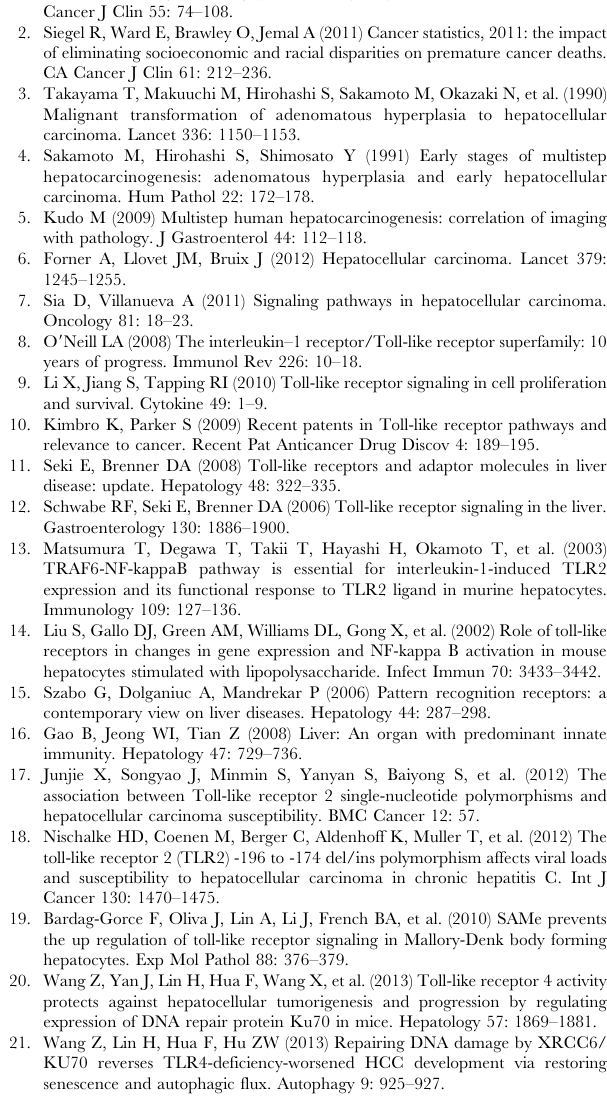
identified in the clone 1 of HepG2 cells. (C) Expression of Bip, phospho-eIF2 a , eIF2 a , CHOP, IRE1 a , phospho-JNK1/2 and JNK1/2 was detected with Western blotting in HepG2 cells over- expressing TLR2 or control vector. Data are representative blots (left panel) and mean 6 SEM (n= 4 per group, right